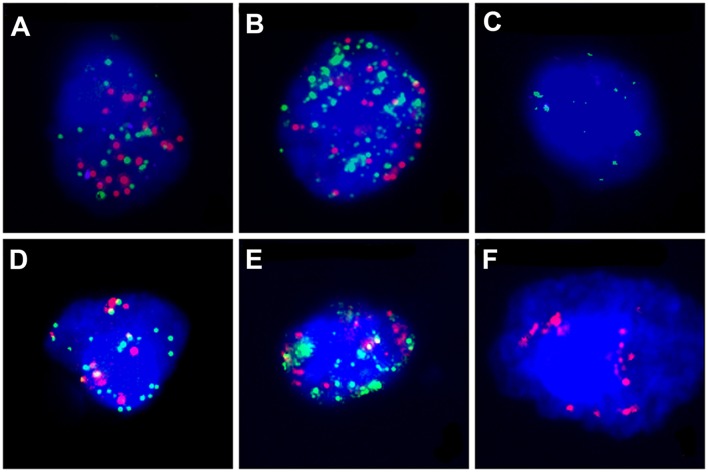
The PD-L1 mRNA expression level and CTC subtypes in CTCs was detected by RNA-ISH. PD-L1: purple fluorescence, epithelial markers: red fluorescence, mesenchymal markers: green fluorescence. (A) Hybrid type CTC with PD-L1(++); (B) Hybrid type CTC with PD-L1(+); (C) Mesenchymal Type CTC with PD-L1(–); (D) Mixed type CTC with PD-L1(+); (E) Hybrid type CTC with PD-L1(–); (F) Epithelial type CTC with PD-L1(–).